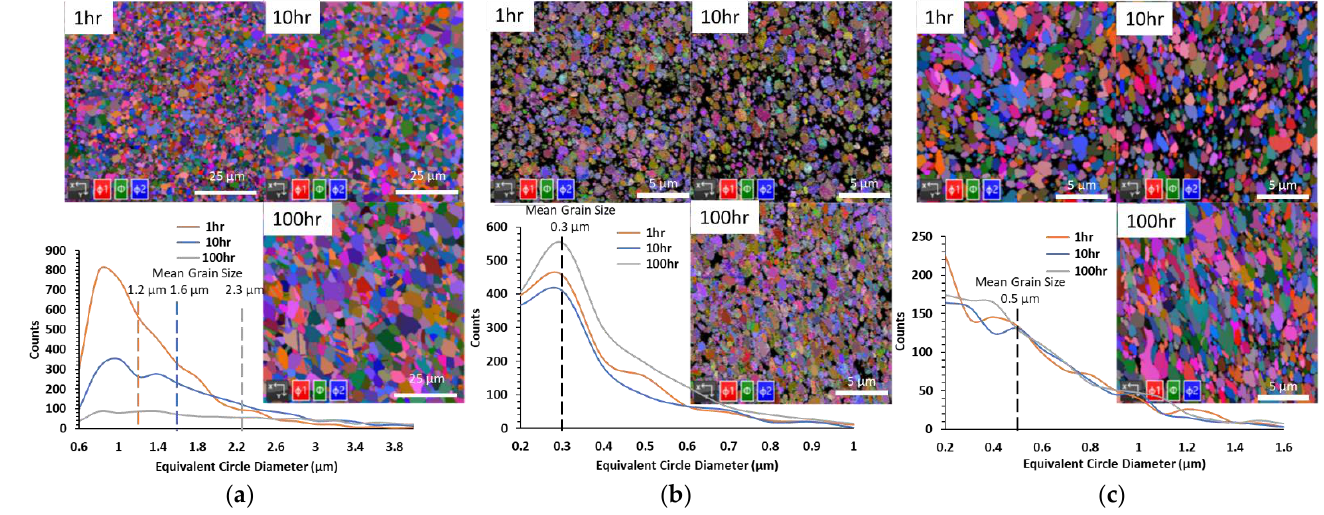
Figure 11. Grain size distribution and orientation for the triple layer TBC ( a ) bond coat, ( b ) YSZ, ( c ) GZ layers.